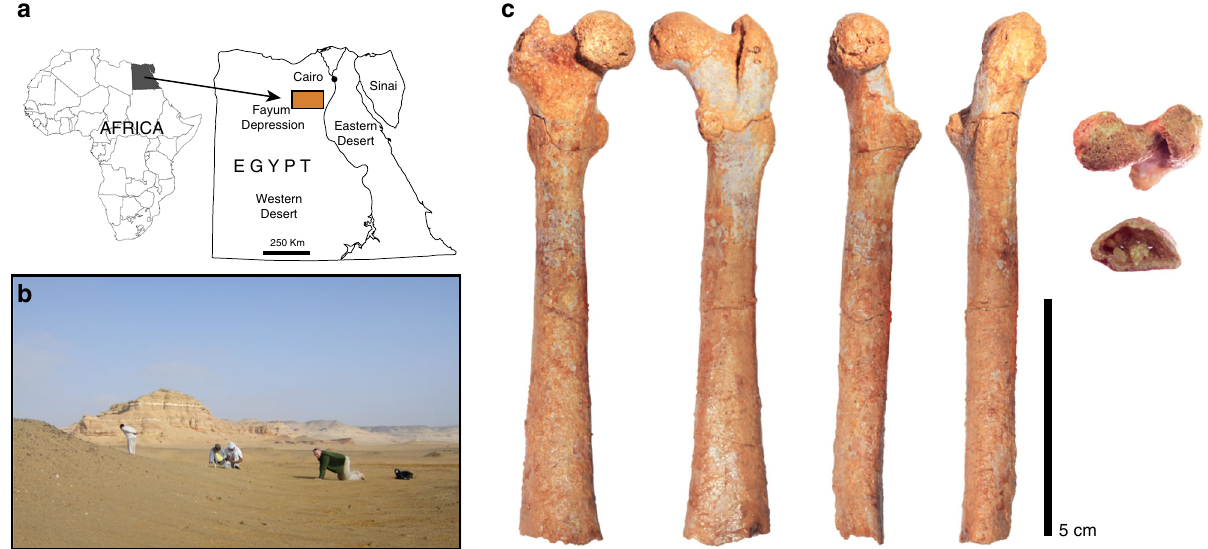
Fig. 1 Site location and views of the new Aegyptopithecus femur (DPC 24466). a Location of the Fayum Depression within Egypt, where the Quarry M locality is. b Detail picture of the Quarry M locality during its survey in 2009 (photo credit: Mark Mathison). c Anterior, posterior, medial, lateral, proximal and distal views, respectively, of DPC